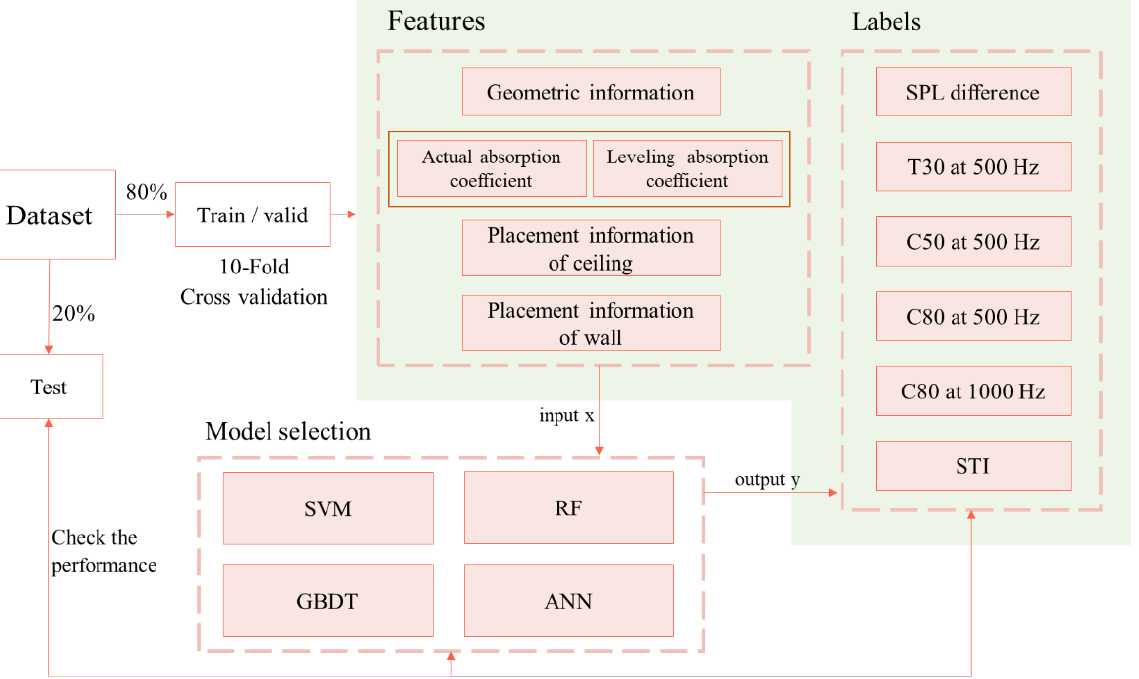
Figure 11. Process of model construction.